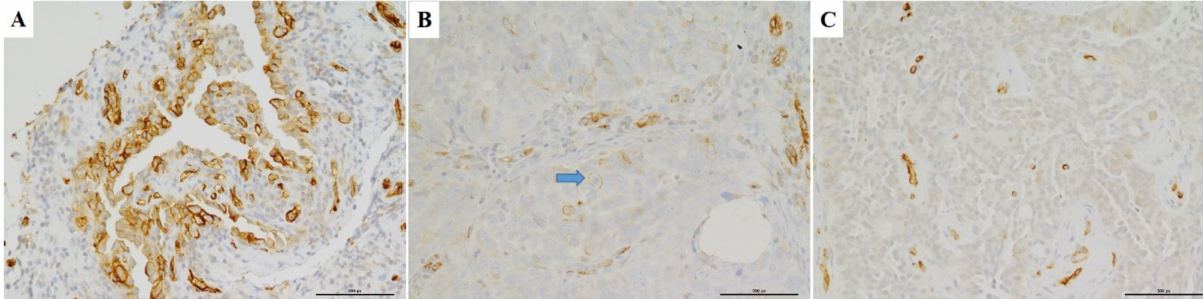
Figure 1. Different Immunohistochemical expression patterns of AQP1 in diagnostic biopsies of high grade serous ovarian carcinomas. ( A ) Diffuse positivity for AQP1 showing linear and circumferential membranous staining is depicted. ( B ) Another serous carcinoma case showing focal staining for AQP1. Arrow indicates a neoplastic cell with linear and circumferential membranous staining. ( C ) Negative staining for AQP1 is depicted. Arrow indicates vascular endothelial cells which served as positive internal control. (A-B-C: IHC, LSAB-HRP, 20 ×